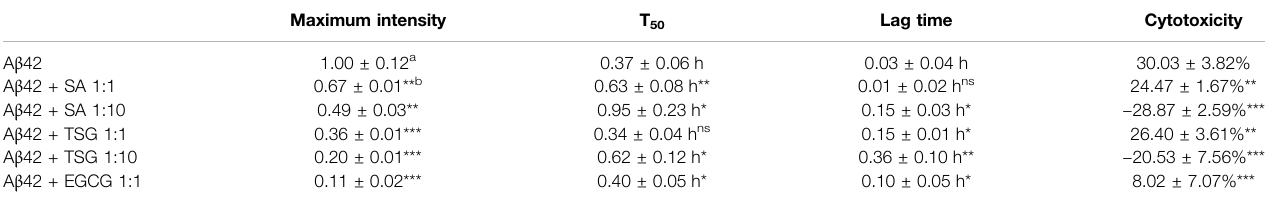
TABLE 1 | Effects of SA, TSG and EGCG on the amyloidogenicity (T 50 , lag lime and maximum fl uorescence intensity) and cytotoxicity of A β 42.